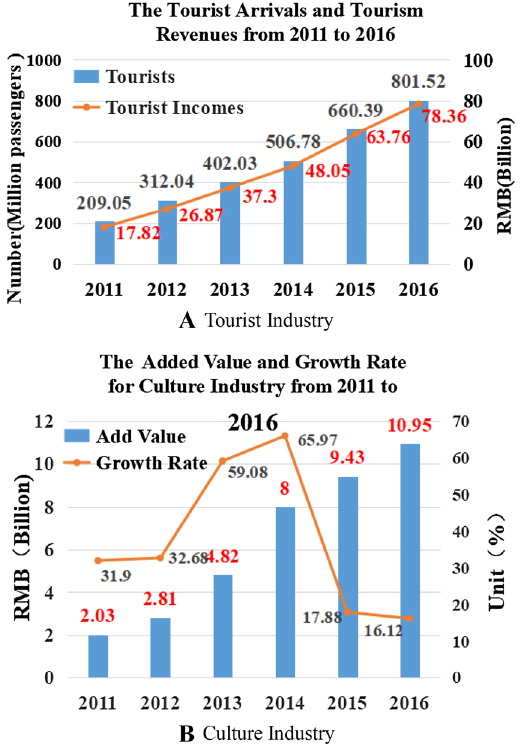
Fig. 4 Two types of economic changes from 2011 to 2016 (Top: tourist industry, Bottom: culture industry)